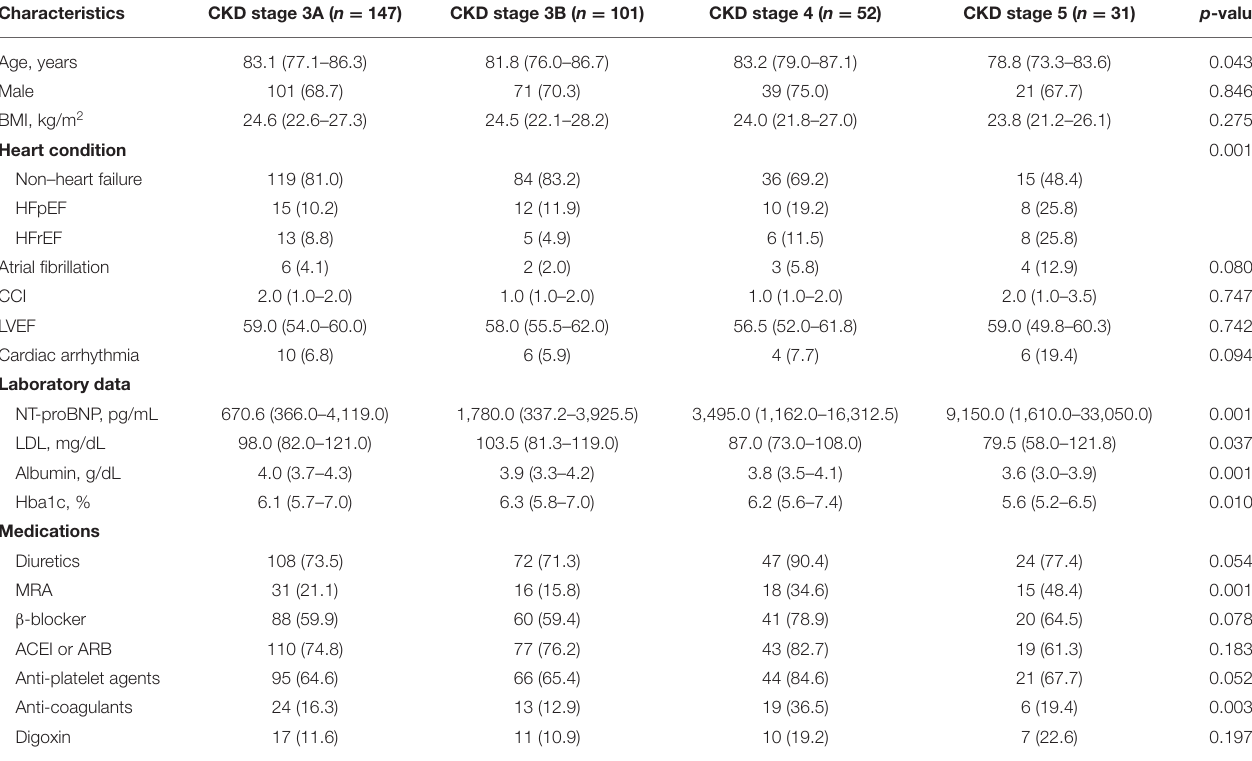
TABLE 1 | Baseline characteristics of older patients with different staging of CKD. Characteristics